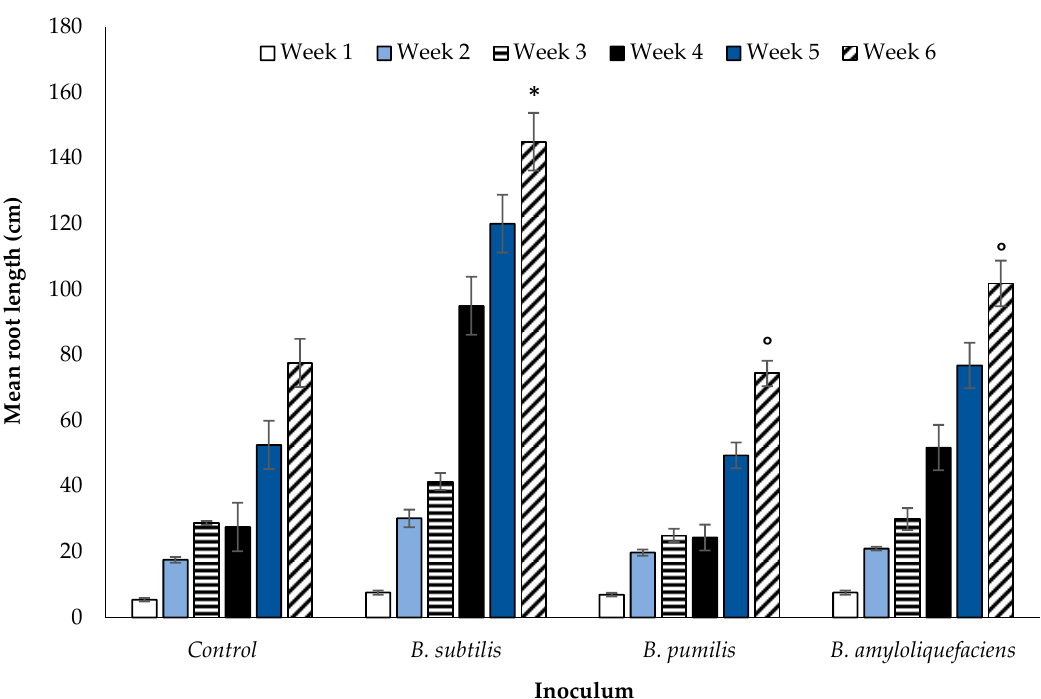
Figure 3. Average (n = 270 overall) root length for inoculated winter wheat over a six week period. Significant ( p < 0.00001) for single factor ANOVA. TRUE Bonferroni corrections (*), FLASE Bonferroni corrections (°). Error bars = one SEM.